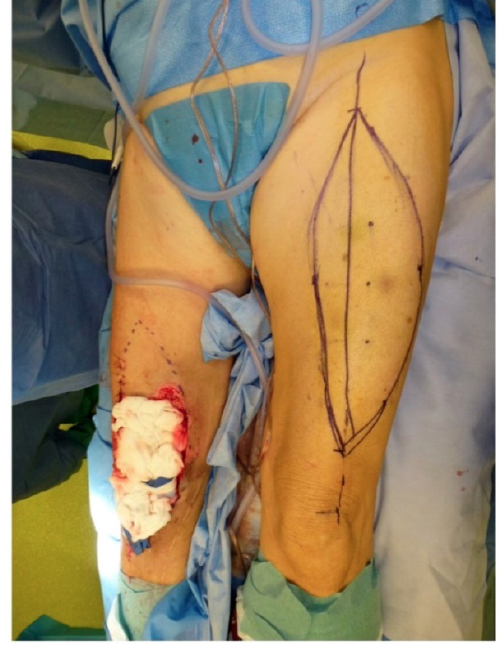
Figure 11: Free ALT with FL: Intraoperative markings to raise the flap to cover the defect around the right knee. The marked dots indicate the skin perforators (identified with a Doppler) off the descending branch of the lateral femoral circumflex artery. Note the planned resection of intact skin proximal to the defect of the right knee to allow flap inset (Table 1: Patient No. 1; additional Figures 3, 10).